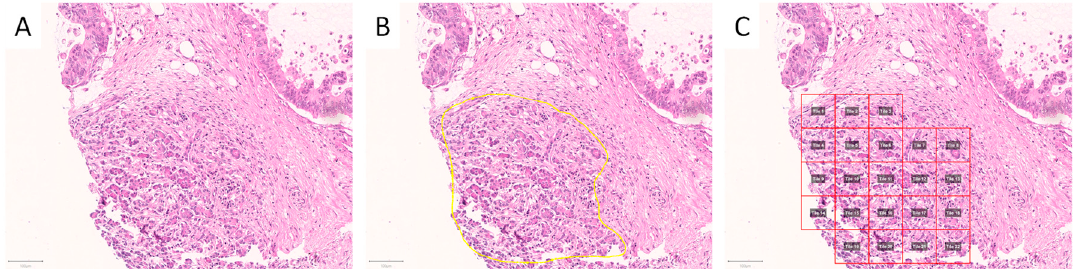
Figure 7. Annotation and generation of image patches. Representative tissue microarray core of a pancreatic specimen without ( A ) and with annotation of exocrine parenchyma (( B ), yellow outline), as well as after image patches’ creation (( C ), red squares). The image patches were subsequently saved as.png files. Scale bars: 100 µ m.